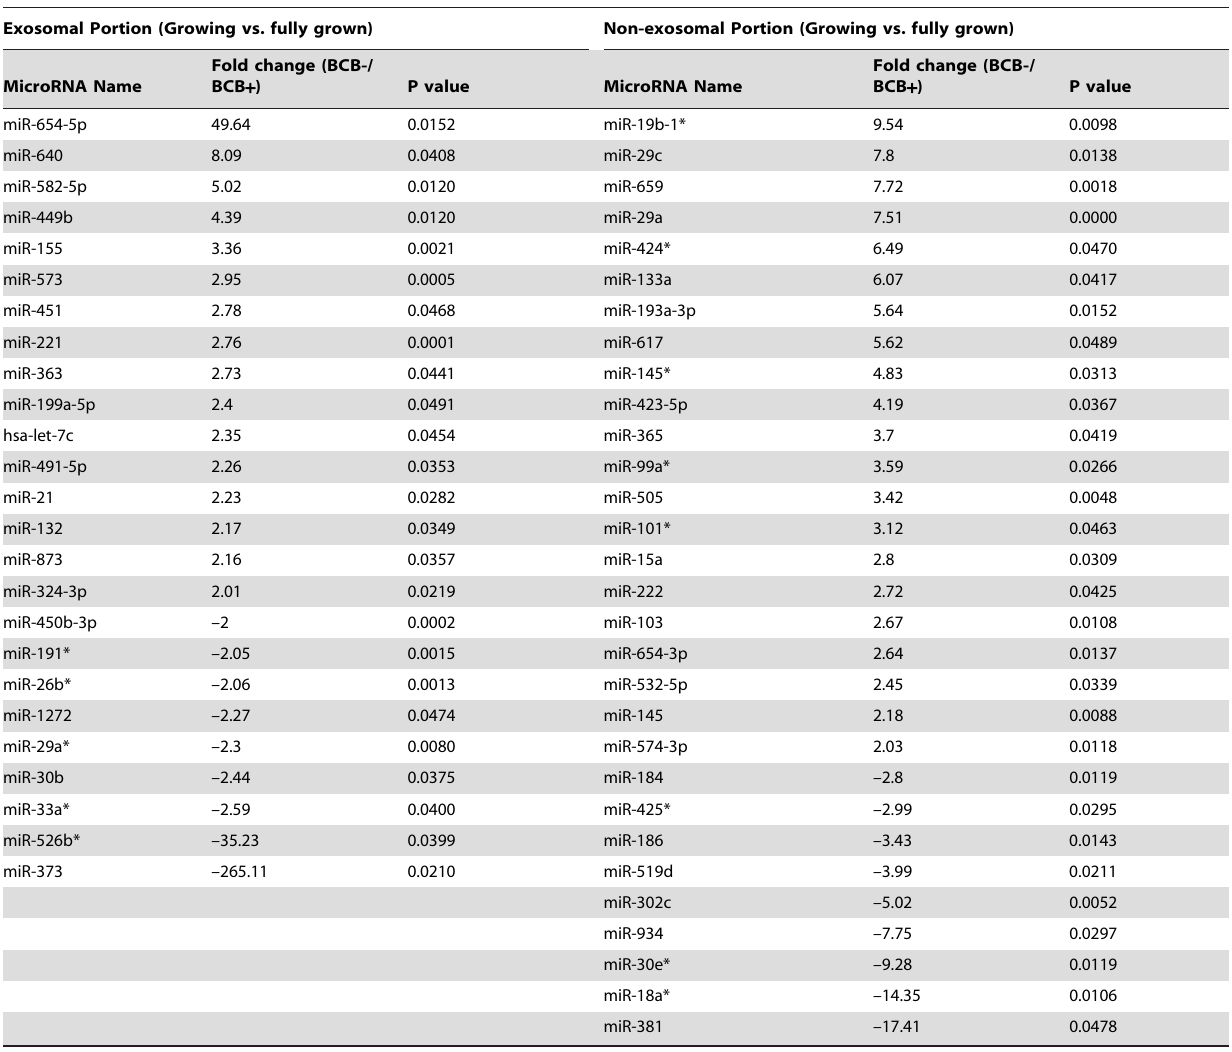
Exosomal Portion (Growing vs. fully grown) Non-exosomal Portion (Growing vs. fully